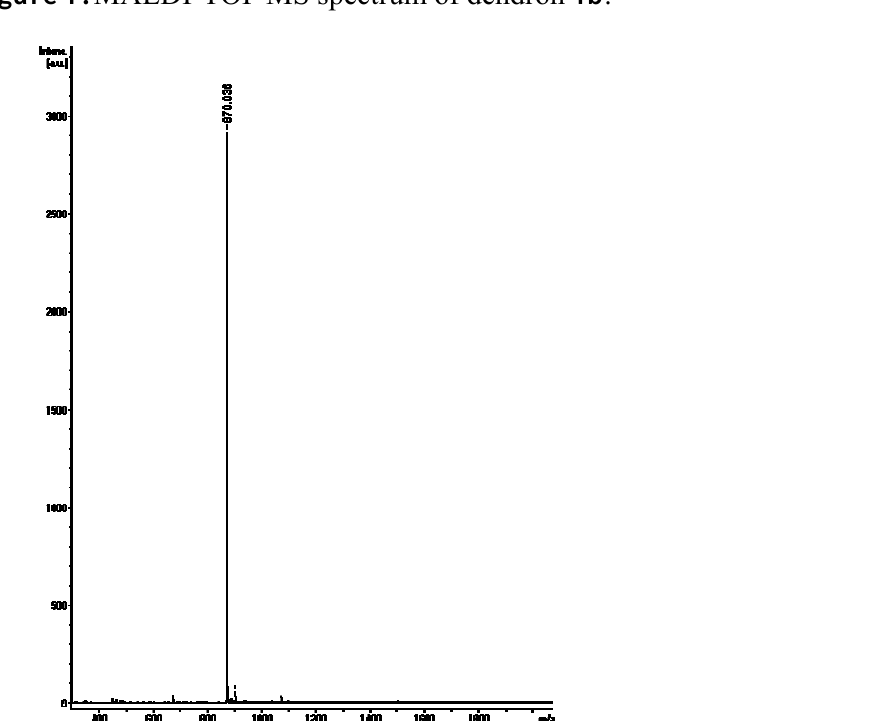
Figure 1. MALDI-TOF MS spectrum of dendron 1b